Question: State the chart type depicted above.
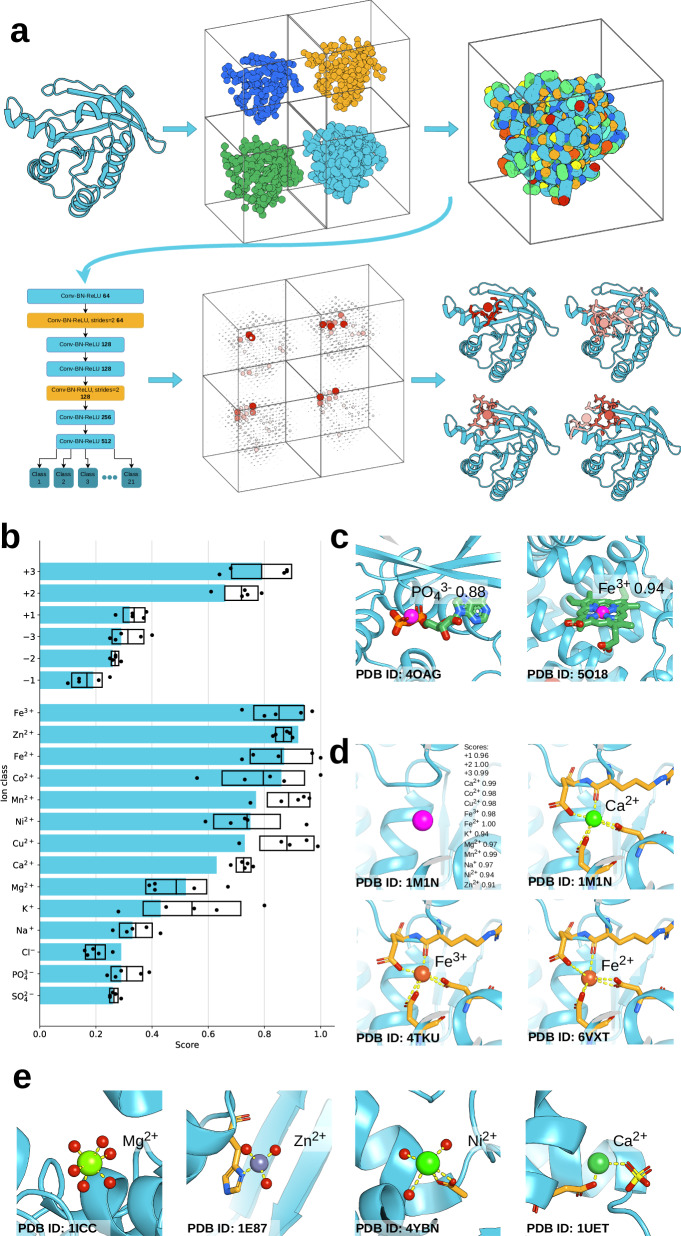
Answer: box